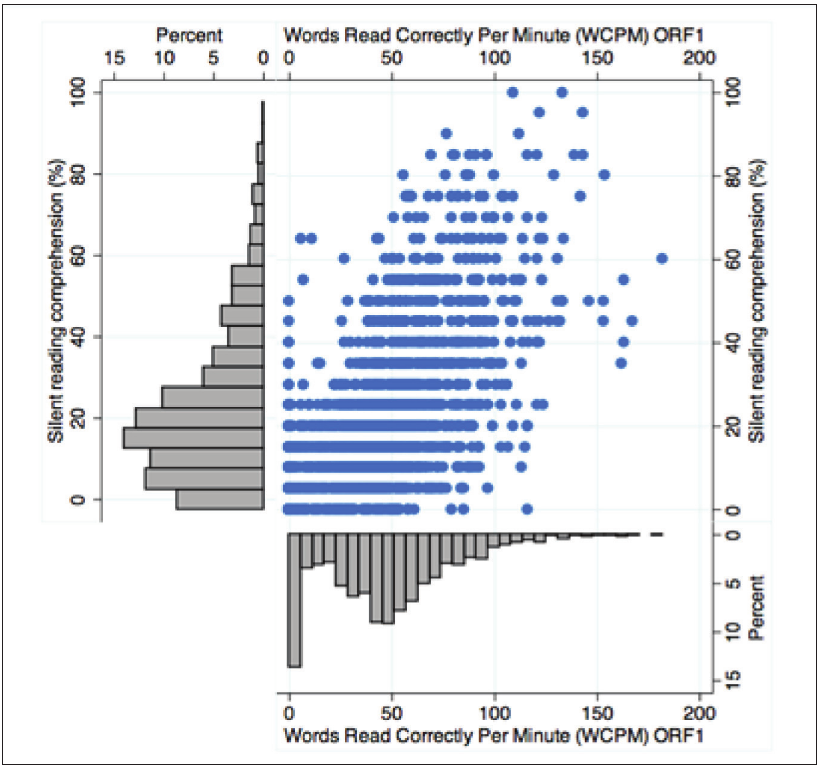
Figure 2: Distributions of silent reading comprehension (in %) and ORF (in WCPM) for the ORF 1 sample (correlation: 0.49; n=1